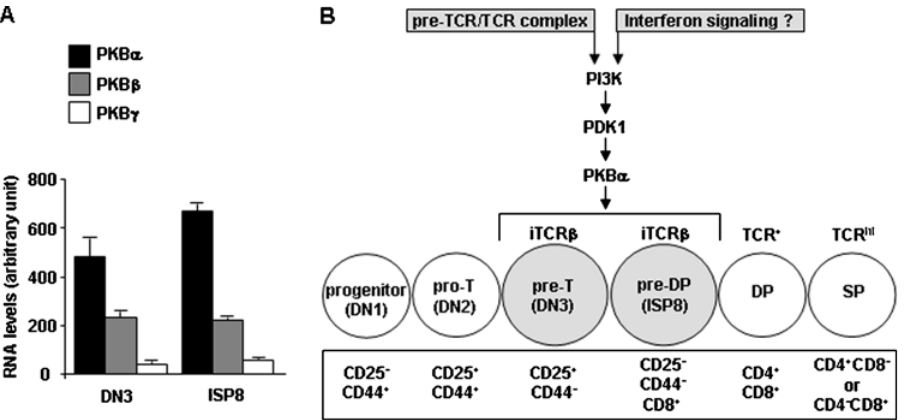
Figure 5. PKB a is the main isoform in DN3 and ISP8 thymocyte subsets. A: mRNA levels of PKB a , PKB b , and PKB c isoforms in DN3 and ISP8 thymocyte subsets. The expression data obtained following microarray analysis were corrected for GC-bias within oligos, allowing gene expression signals to be expressed on the same scale; this permits a semi-quantitative comparison of the expression of different genes. B: Proposed model of PKB a mediatingPI3K signaling at the transition from DN to DP thymocyte subsets. iTCR b and TCR refer to intracellular and surface expression of TCR b ,